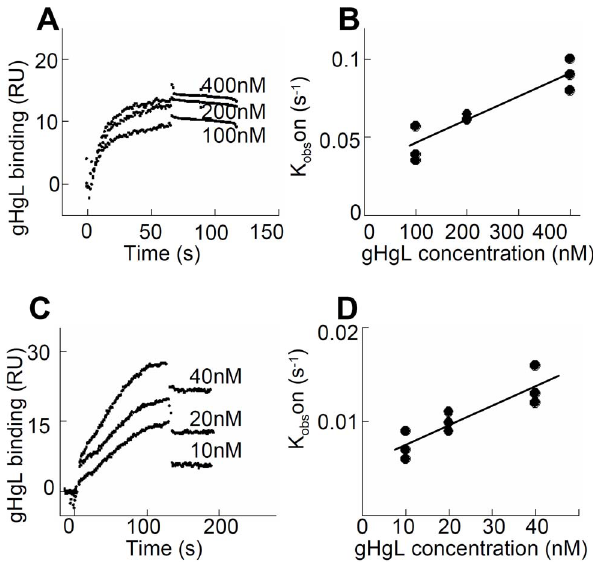
Figure 1. A soluble form of HSV gH/gL binds soluble a v b 6- and a v b 8–integrin at high affinity. (A and C) Surface Plasmon Resonsance spectroscopy was performed to evaluate binding of different concentrations of gH/gL, as indicated, to immobilized a v b 6- integrin (A) and a v b 8-integrin (C). (B and D) Linear plots of k obs versus gH/gL concentration for the gH/gL interaction with a v b 6-integrin (B) and a v b 8-integrin (D). The intersection points with the Y axes correspond to the dissociation rates constants k off and the slopes to the association rate constants k on . Three independent experiments were performed for each integrin and results were plotted together without normalizing.